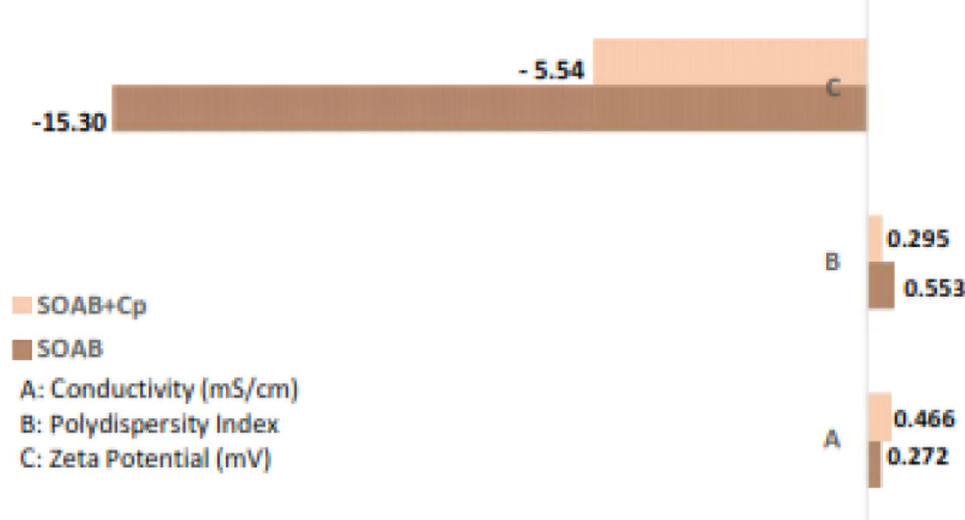
Fig. 1 Conductivity, polydispersity index (PDI), zeta potential of Sesamum indicum oil based nanoemulsion (SOAB) and Ciprofloxacin-loaded Sesamum indicum oil based nanoemulsion (SOAB +